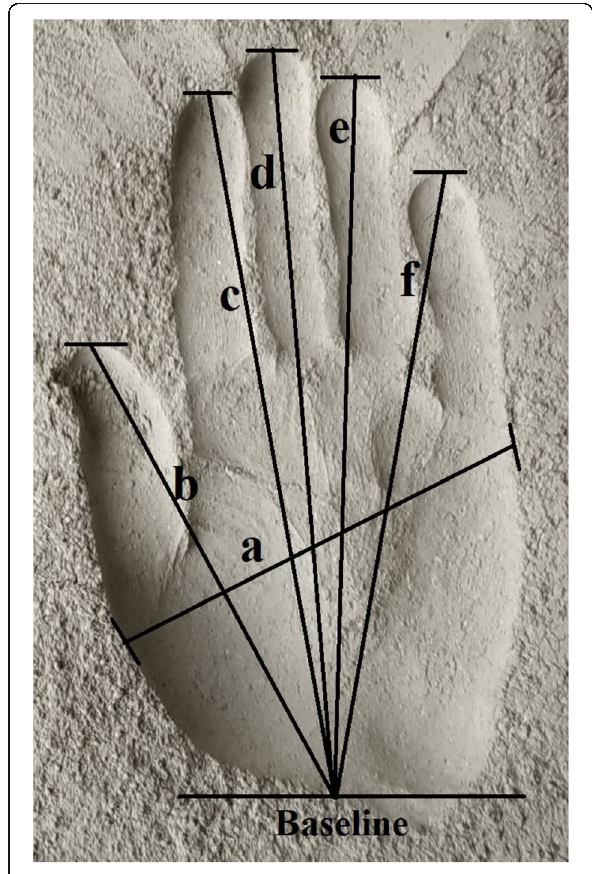
Fig. 2 Handprint measurements: a maximum handprint breadth; b 1 st digit length; c 2 nd digit length; d 3 rd digit length; e 4 th digit length; f 5 th digit